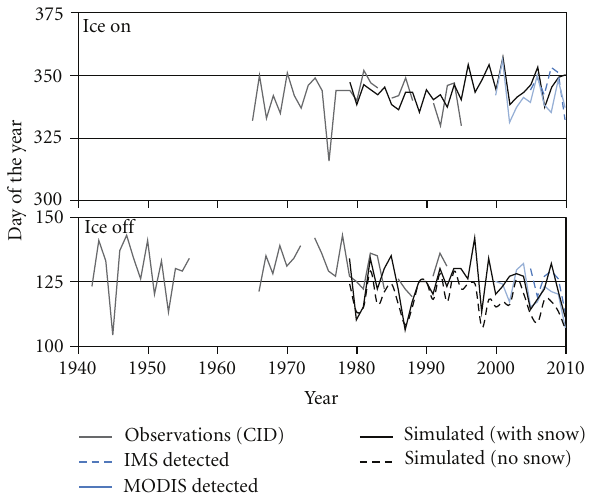
Figure 9: Ice-on/o ff dates for L. St. Jean for simulations (1979– 2010), MODIS (2000–2010), IMS (2004–2010), and in situ obser- vations